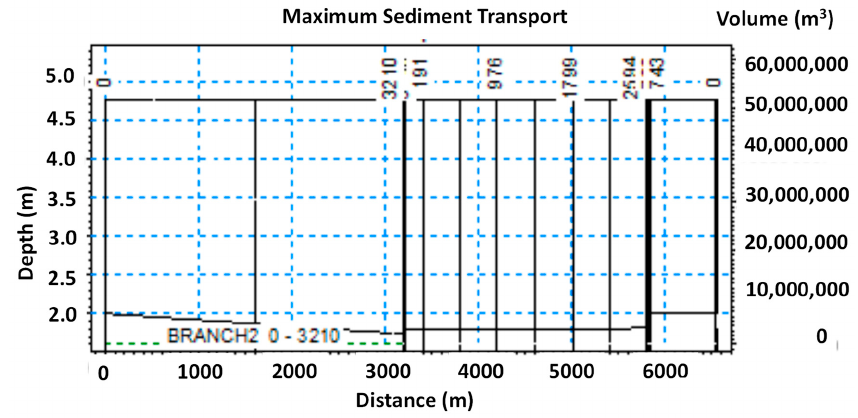
Figure 13. Sediment movement in the tc-7 tertiary channel has a sluicegate